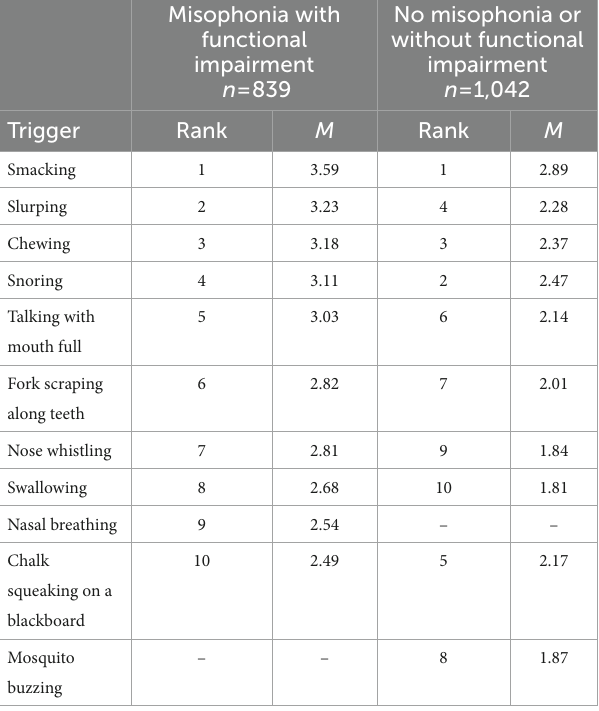
Figure 1. In the AMISOS-R, emotional reactions (irritation, anger, disgust, and other) are either affirmed or denied. The most frequently affirmed reaction was irritation (94% vs. 88% in the clinically impaired vs. non-impaired group), followed by anger (80% vs. 55%), and disgust (42% vs. 30%).